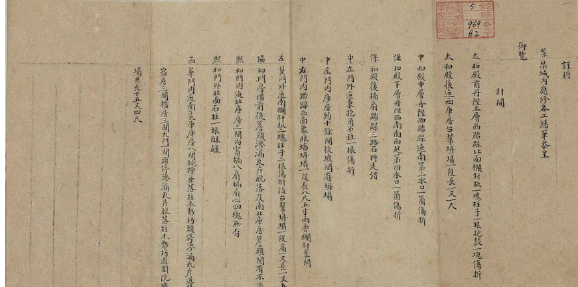
Figure 2. A memorial in 1889 that described the deterioration of several parts near Taihe